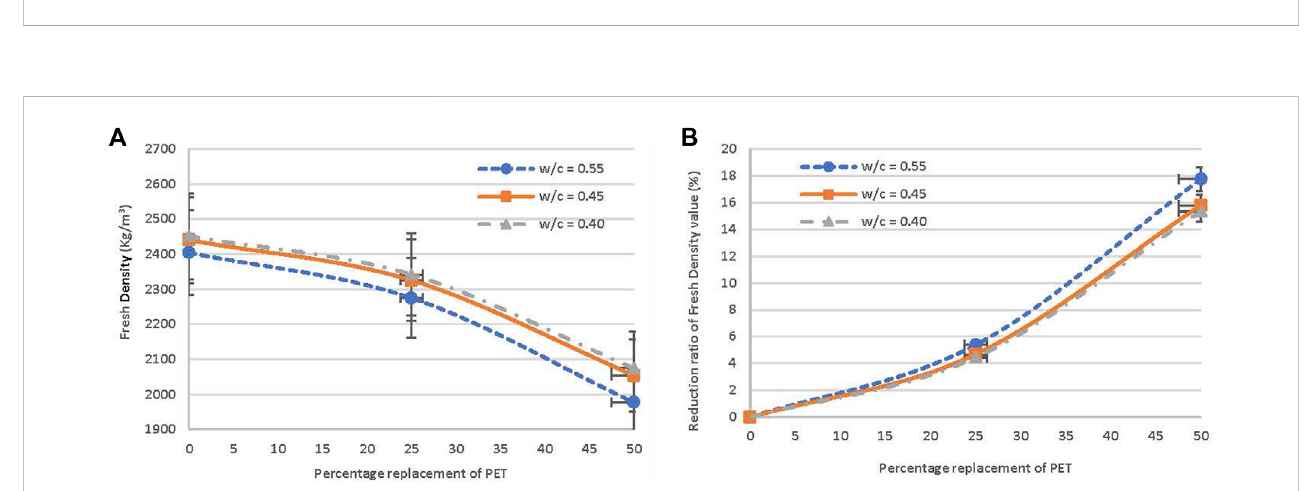
Fresh density test results for different ratios of PET and w/c: (A) fresh density value; and (B) reduction